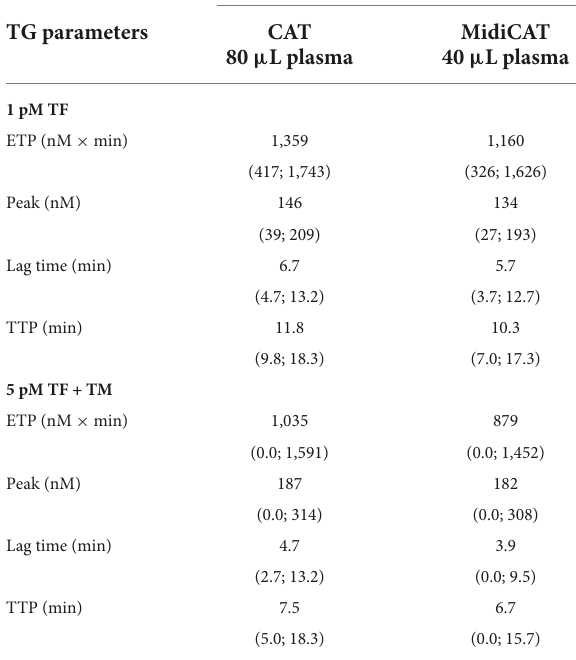
TABLE 1 Median values and ranges of thrombin generation studies with the reference method and MidiCAT